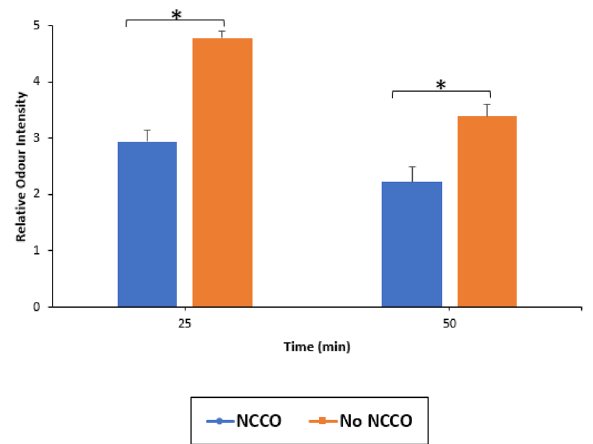
Fig. 6 Summary of relative odour intensity ( n = 18), error bar repre- sents 1 SEM. * p < 0.05